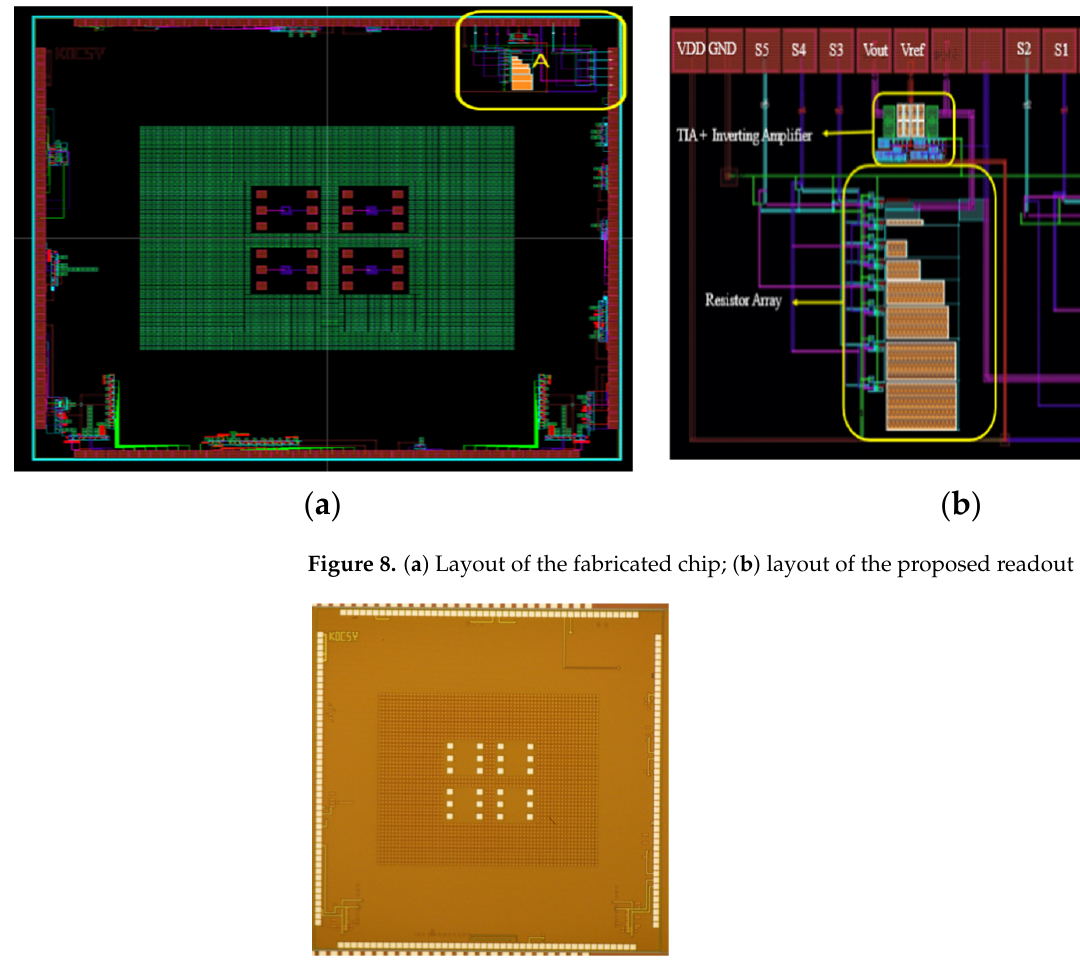
Figure 9. Photo of the fabricated chip.